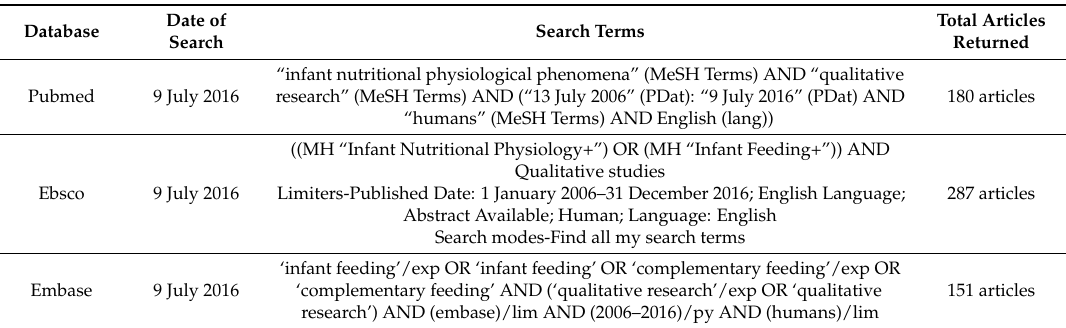
Table S1: ENTREQ checklist (Enhancing transparency in reporting the synthesis of qualitative research). Acknowledgments: No funding was provided for this study. All authors have read and approved the final